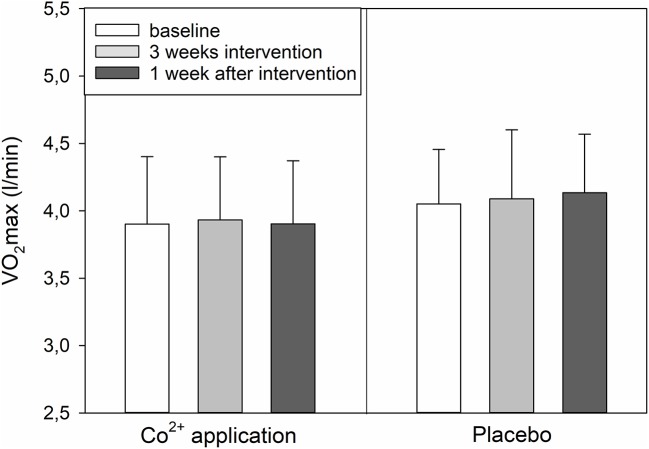
Changes in VO2max immediately and 1 week after the 3-week cobalt application period.